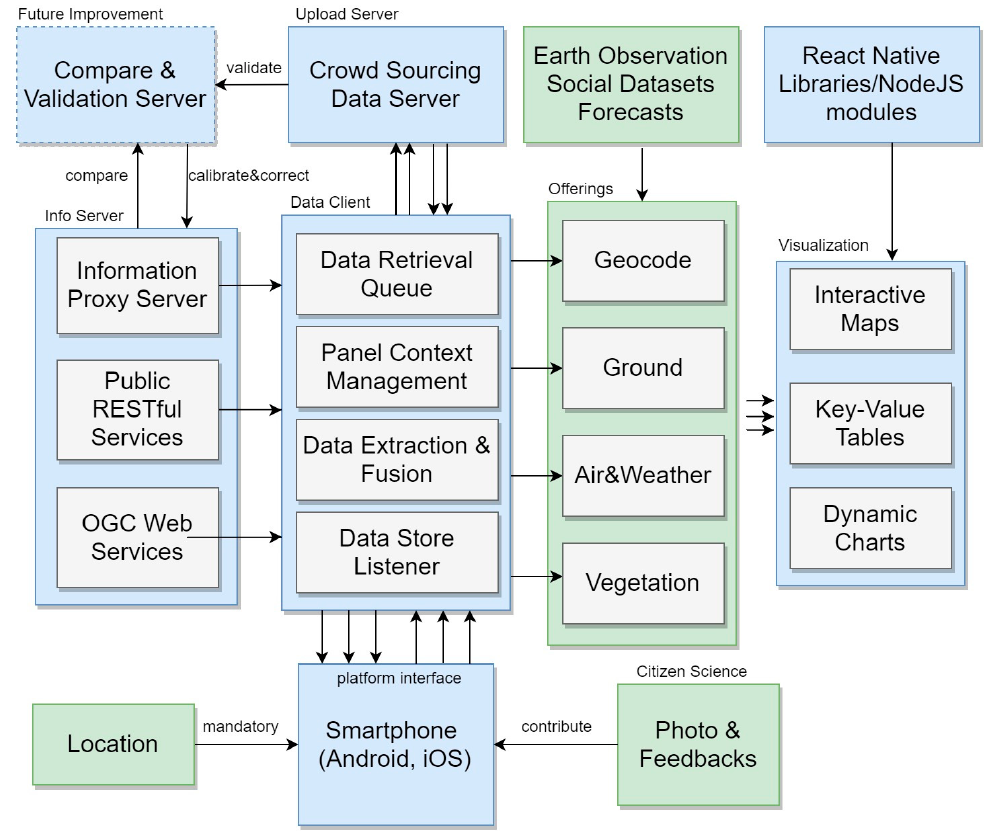
Figure 3. System architecture (blue boxes—software components; green boxes—data).